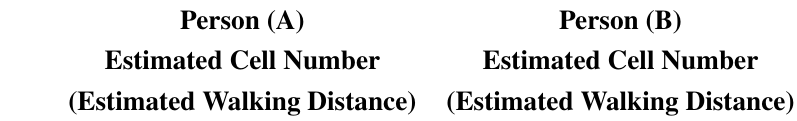
Table 5. Location estimation accuracy test.